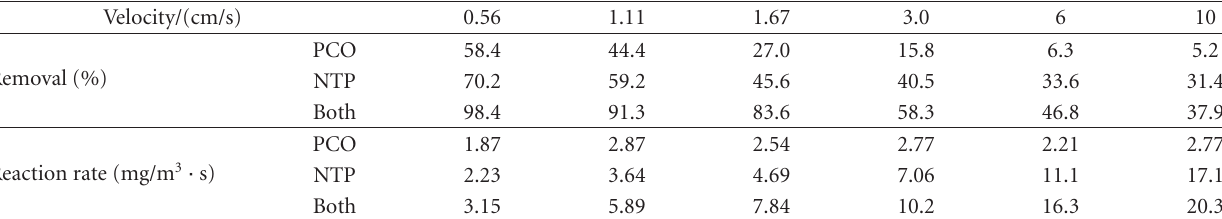
Table 1: The synergistic e ff ect of NTP and